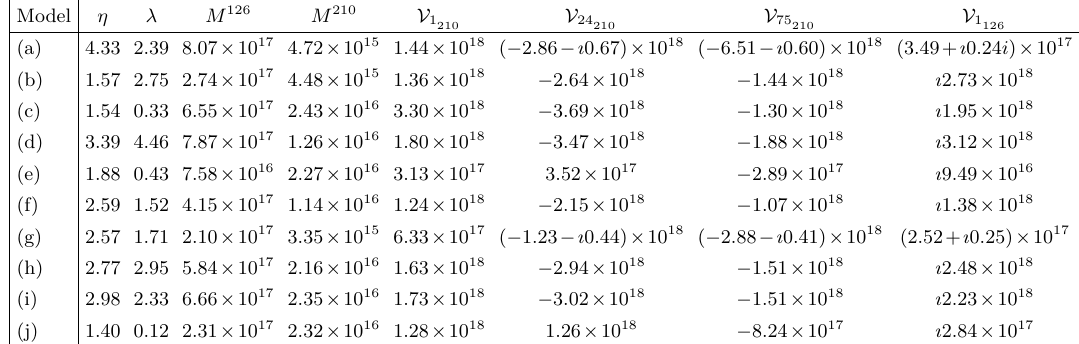
Table 1 . A numerical estimate of the VEVs of the Standard Model singlets in 210 , 126 and 126 - plets arising in the spontaneous breaking of the SO(10) GUT gauge symmetry under the assumption = V . All VEVs and masses are in GeV. V 1 1 126 126